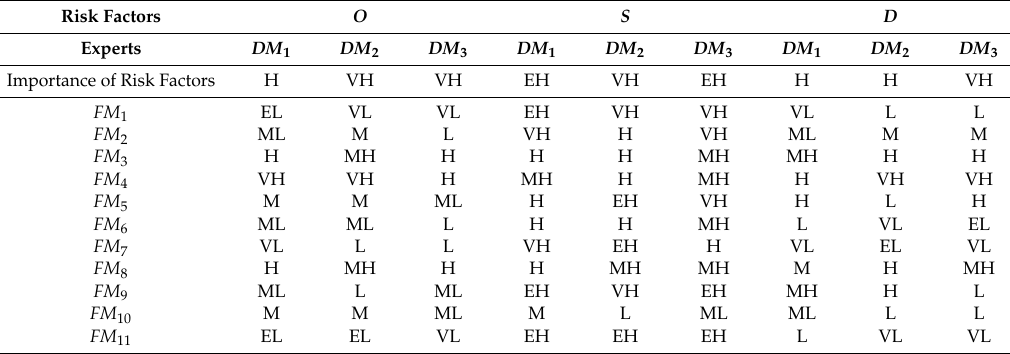
Table 2. Evaluation information from experts using linguistic